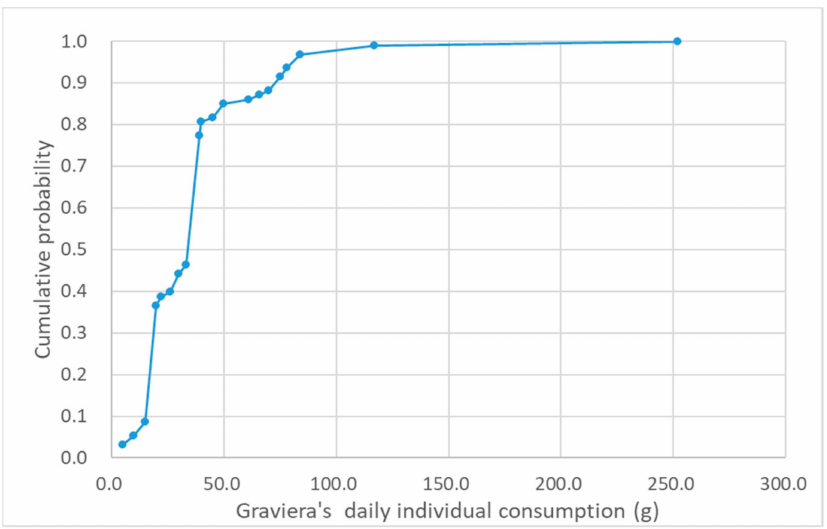
Figure 2. Cumulative frequency graph of Greek adults’ daily individual consumption of graviera (g) based on data of 93 healthy adult Greek consumers extracted from the Hellenic National Nutrition and Health Survey (HNNHS)